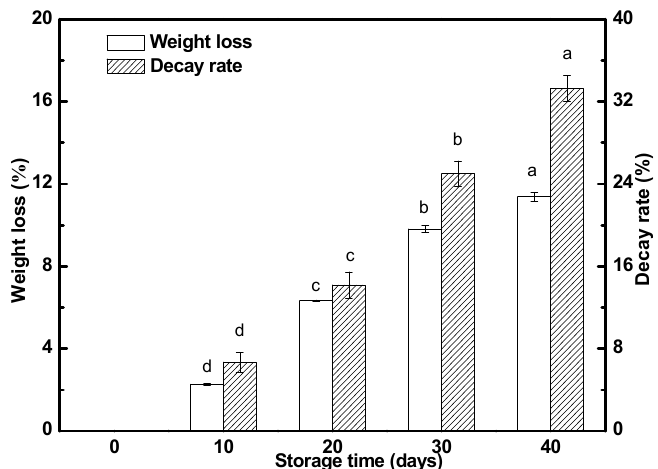
Figure 1. Postharvest weight loss and decay rate of the ‘Satsuma’ mandarin fruits stored at 25 °C with a relative humidity of 85–90% for 40 days. Data are means ± SD in three replicates. Columns for the same index marked by different letters are significantly different at p < 0.05.